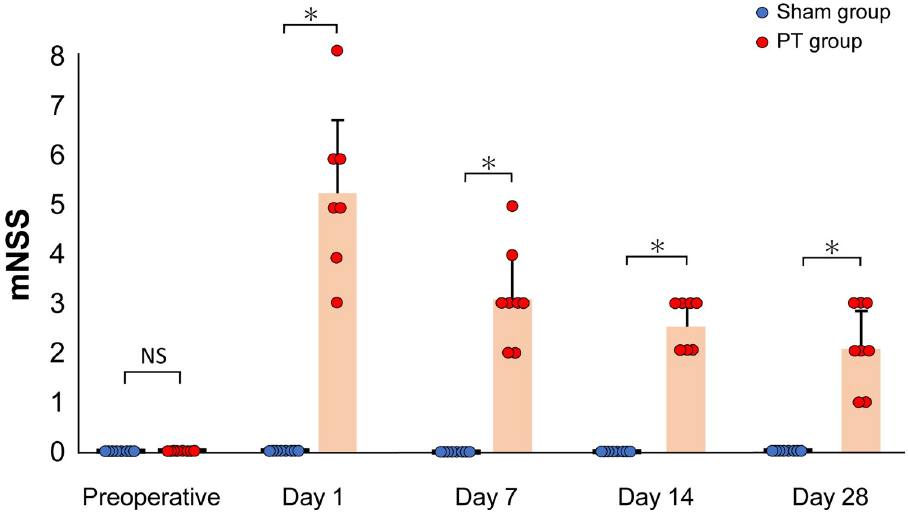
Fig 3. Time course of changes in the modified neurological severity score. Neurological function tests were performed on rats in the sham and photothrombosis (PT) groups at each time point. There were significant differences ( � P < 0.01, Student’s t-test) in the mNSS of each group. Values are represented in mean ±